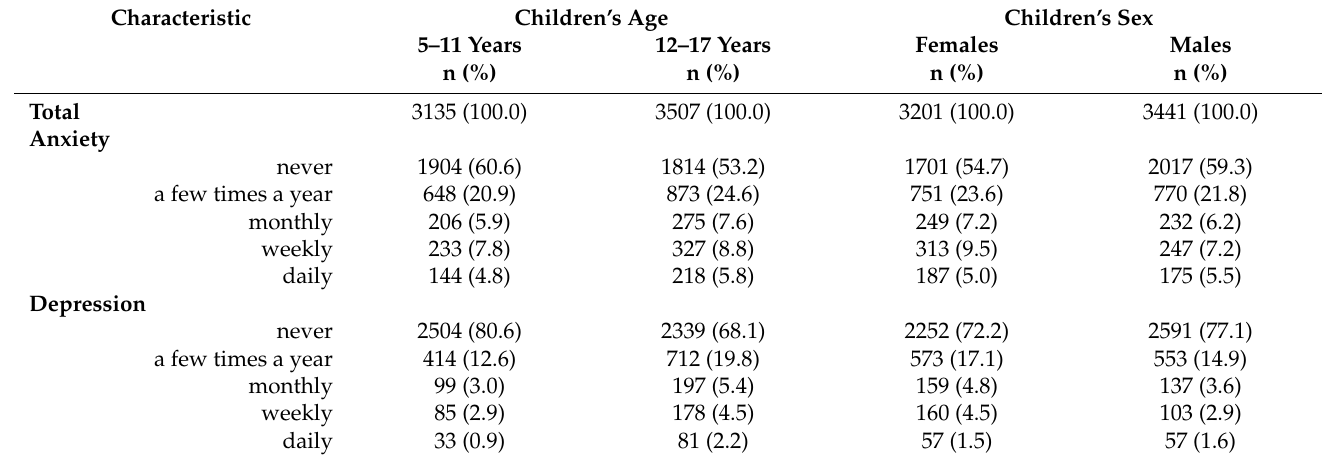
Table 6. Sample size for stratified analyses—2019 National Health Interview Survey (n = 6642)